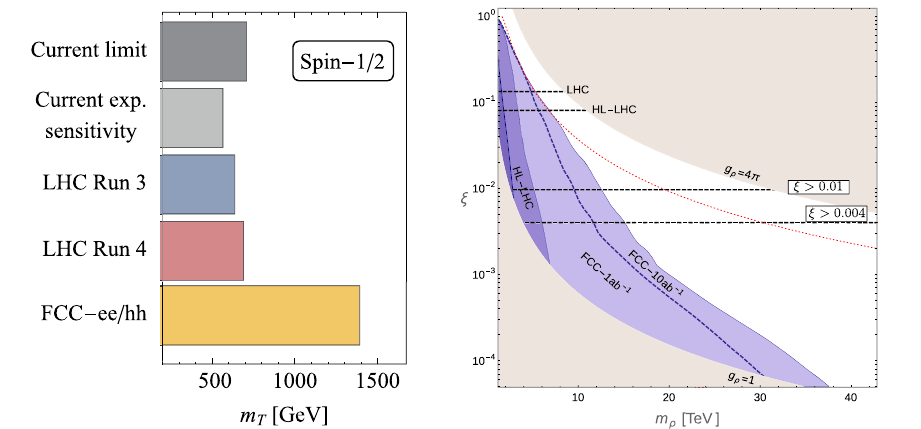
Fig. 9.3 Left: projected 2 σ indirect reach from Higgs coupling con- straints on fermionic top partners from FCC-ee and FCC-hh [278]. Right: in increasingly lighter shades, current LHC and projected future HL-LHCandFCC-hhdirectdiscoveryreachforheavycompositevector